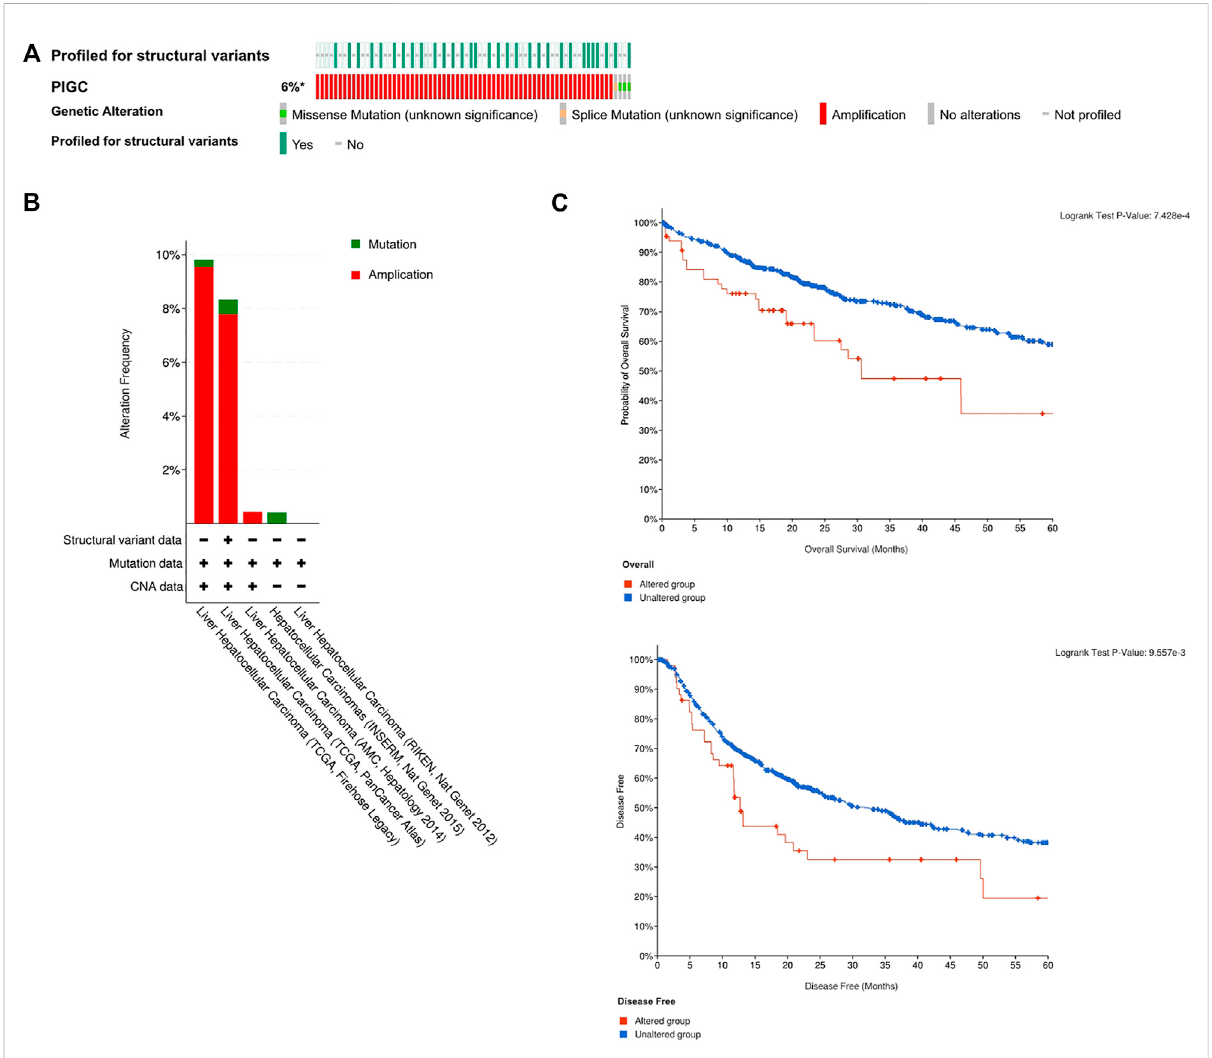
FIGURE 5 The pro fi le ofthe PIGC mutation (A) The pro fi le of the PIGC mutation oftheCbio Portal. (B) The alteration frequencyof differentHCC datasets. (C) The Kaplan – Meier plot of the Correlation of PIGC Expression and